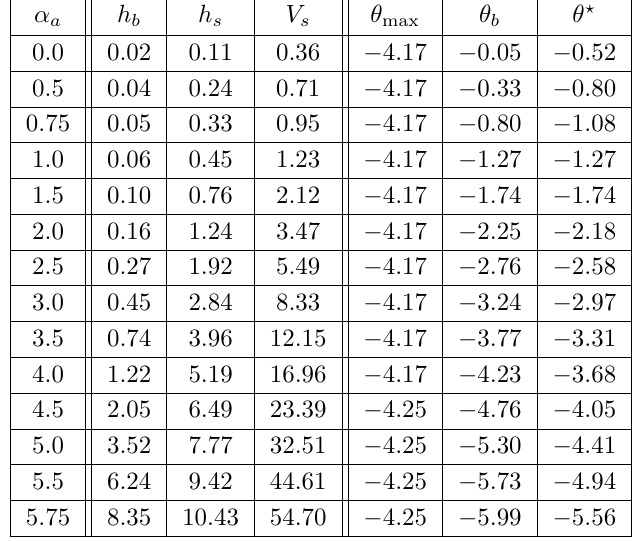
Table 3 . Spectral density’s persistent peak data for σ = 12 , α m = 7 . 5 , that is κ = 1 . 5 .